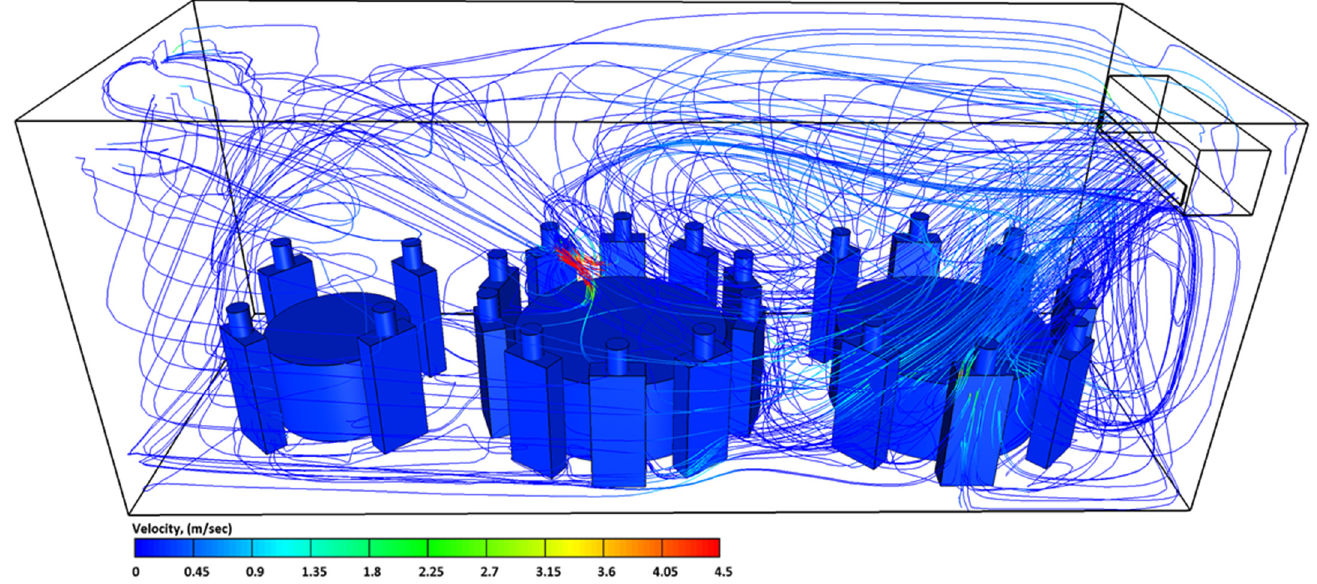
Figure 13. The airflow streamlines velocities in the computational domain at t = 603 s for case-4.